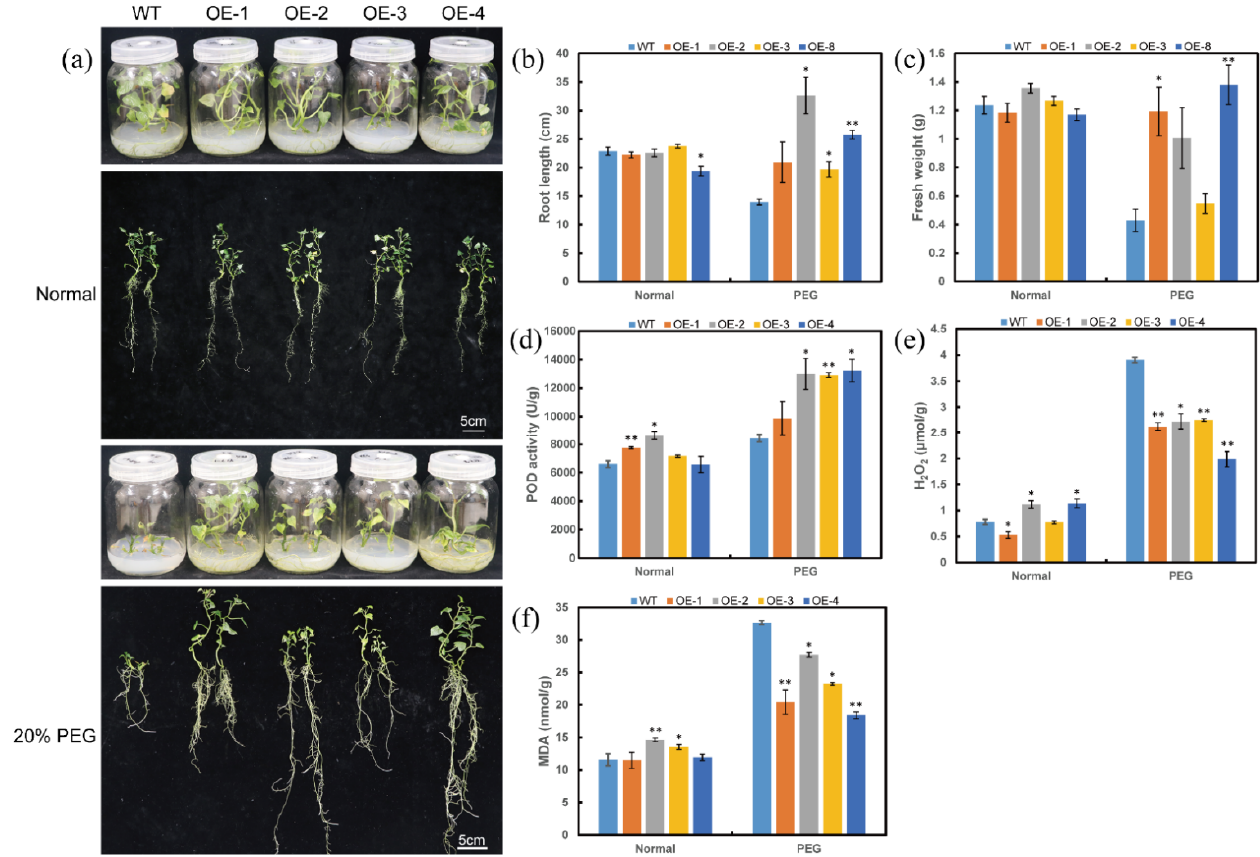
Figure 5. Responses of transgenic and WT sweet potato plants cultured for 4 weeks on MS medium without stress (normal), or 20% PEG6000. ( a ) Phenotypes, ( b ) Root length, ( c ) Fresh weight, ( d ) POD activity in the transgenic and WT plants, ( e ) H 2 O 2 content, ( f ) MDA content. Data are presented as the means ± SE ( n = 3). * and ** indicate a significant difference compared to the WT at p < 0.05 and p < 0.01 based on Student’s t -test, respectively.